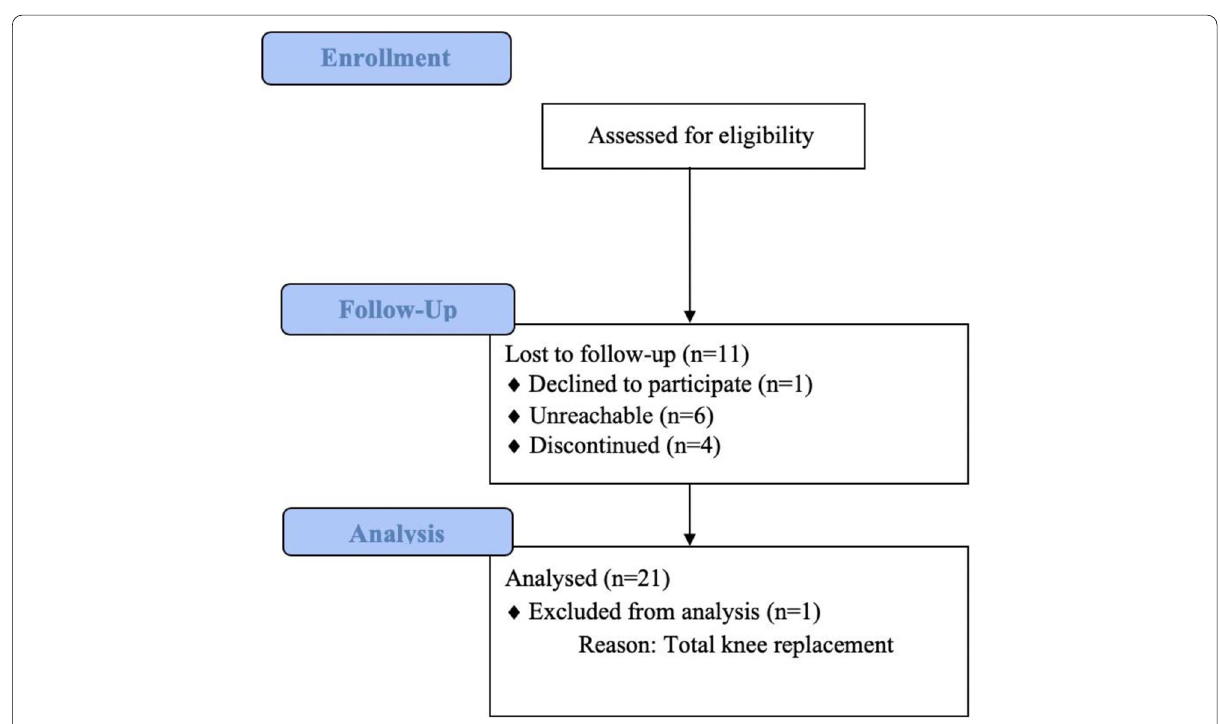
Fig. 1 Study flowchart of the patients included in the study